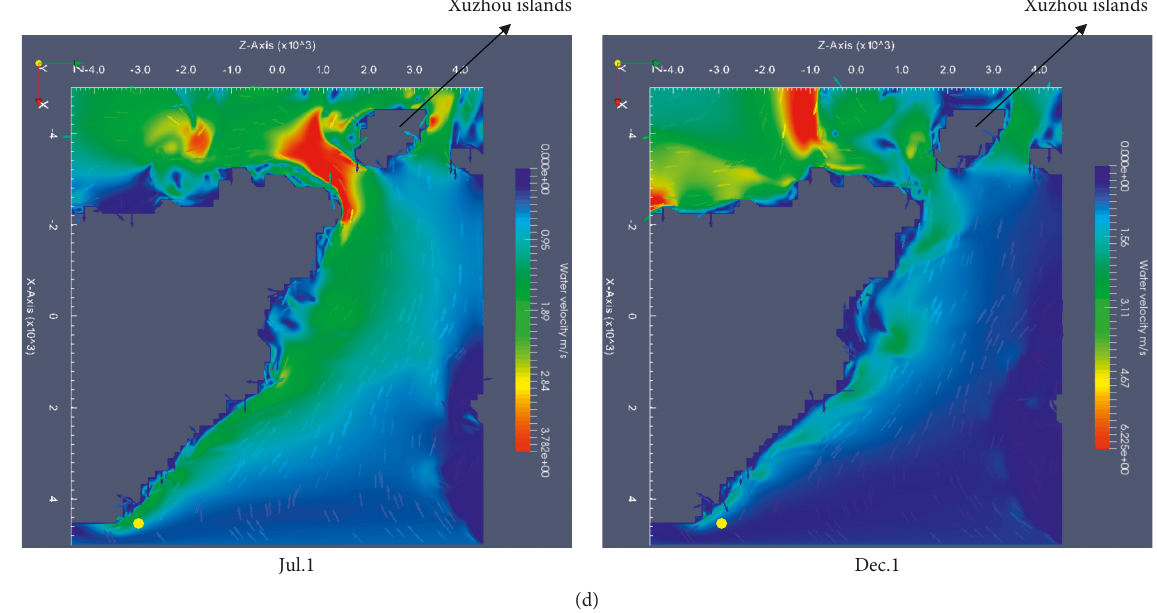
Figure 7: Simulation of the water flow field in 12 hours on Jul. 1 and Dec. 1, respectively. (a) t � 1 h. (b) t � 4 h. (c) t � 11h. (d) t � 12h.